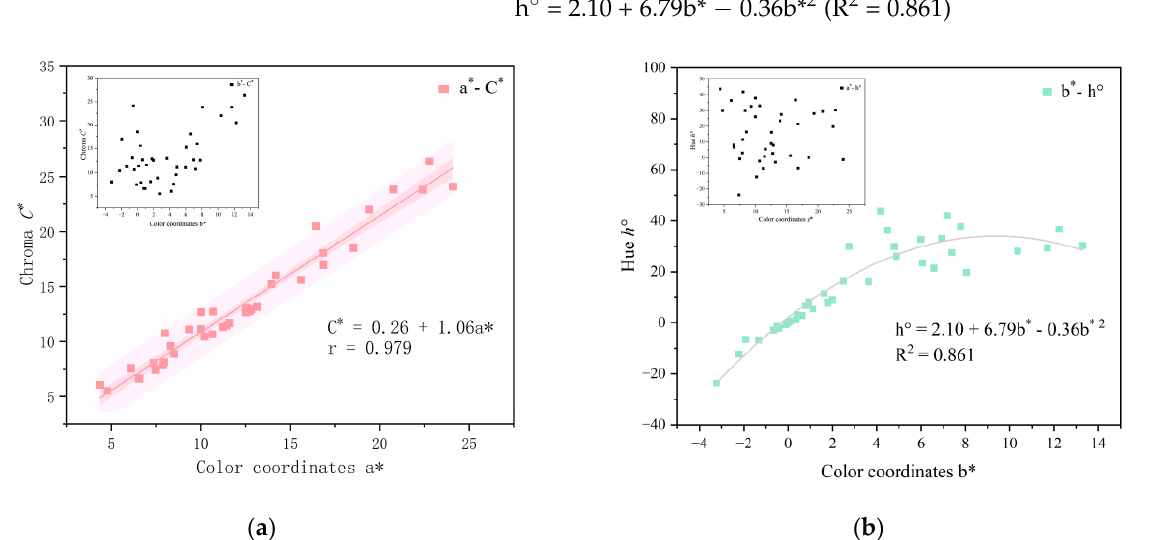
Table 1. Correlation analysis between spinel color parameters under D65 light source. **At level 0.01 (double tail), the correlation was significant.